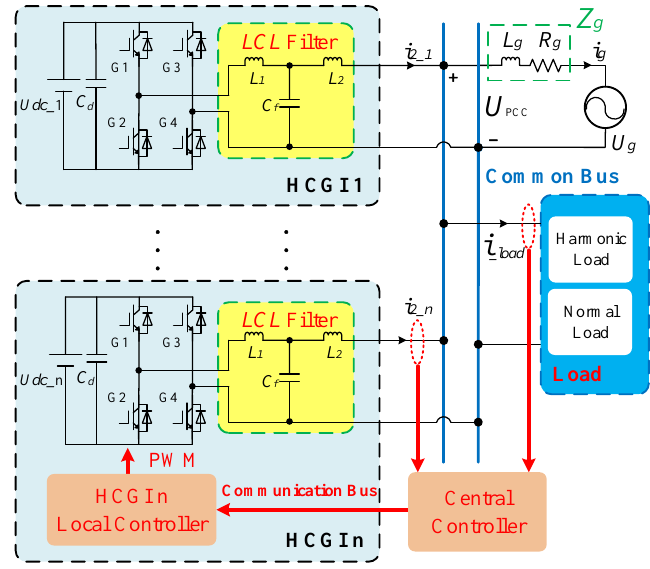
Figure 1. Configuration of a multi-parallel HCGIs system.